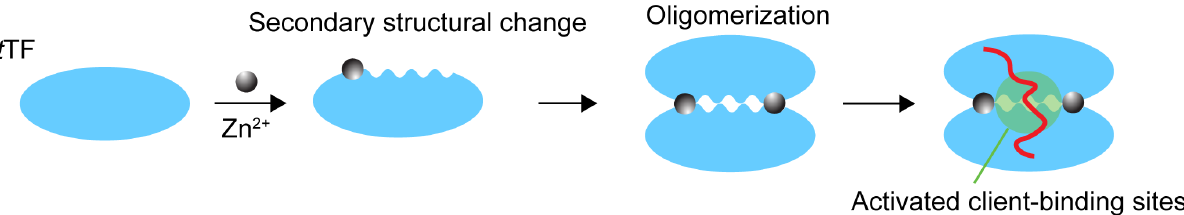
Figure 5. Schematic representation of a possible mechanism for the zinc-dependent activity modulation of Tt TF. Zn 2+ induces the partial structural changes and promotes the oligomerization of Tt TF. Oligomerization can assemble the client-binding sites that enables the efficient client binding, as seen in the dimeric Ec TF. The client protein is represented as a red line.